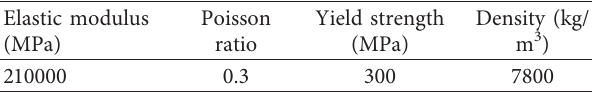
Table 8: Steel material parameters.